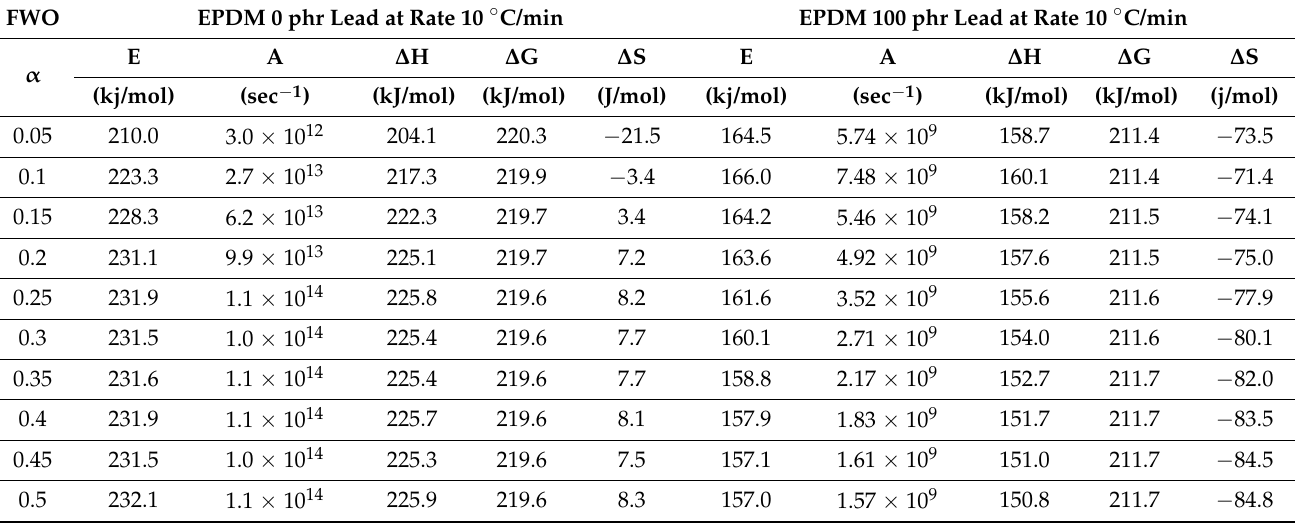
Table 8. The activation energy, pre-exponential factor, and thermodynamic parameters